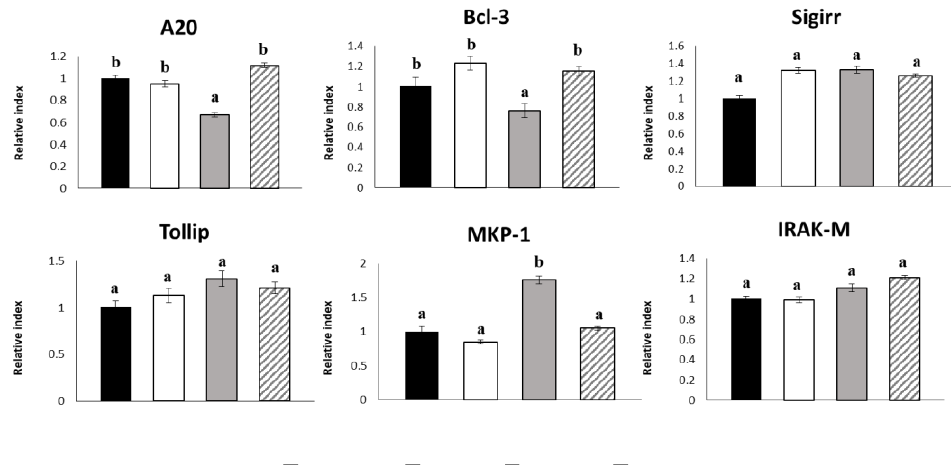
Figure 4. Effect of Lactiplantibacillus plantarum CRL681, CRL1506 or TL2677 on the expression of negative regulators of the Toll-like receptor (TLR) signaling pathway in porcine intestinal epithelial (PIE) cells after Enterotoxigenic Escherichia coli (ETEC) challenge. PIE cells were pre-treated with CRL681, CRL1506 or TL2677 strains for 48 h and then stimulated with heat-stable ETEC pathogen-associated molecular patterns (PAMPs). Non-lactobacilli treated cells were used as controls. The expression of negative regulators of the TLR signaling pathway were studied at 12 h after heat-stable ETEC PAMPs challenge. The results represent three independent experiments. Results are expressed as mean ± SD. Bold letters indicate significant differences when compared to the control group ( p <